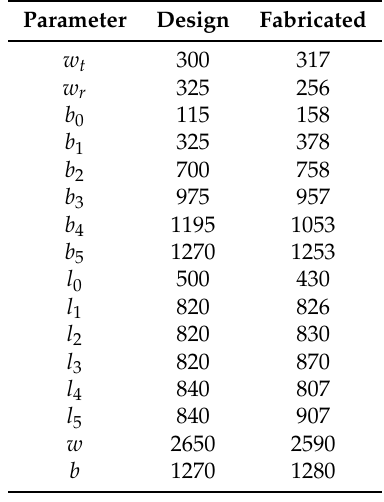
Table 3. Dimensions of the second transition; see Figure 1 for reference. All dimensions in µ m.